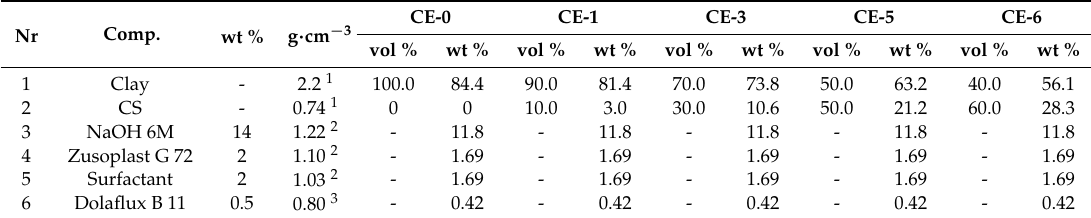
Table 1. Composition and designation of